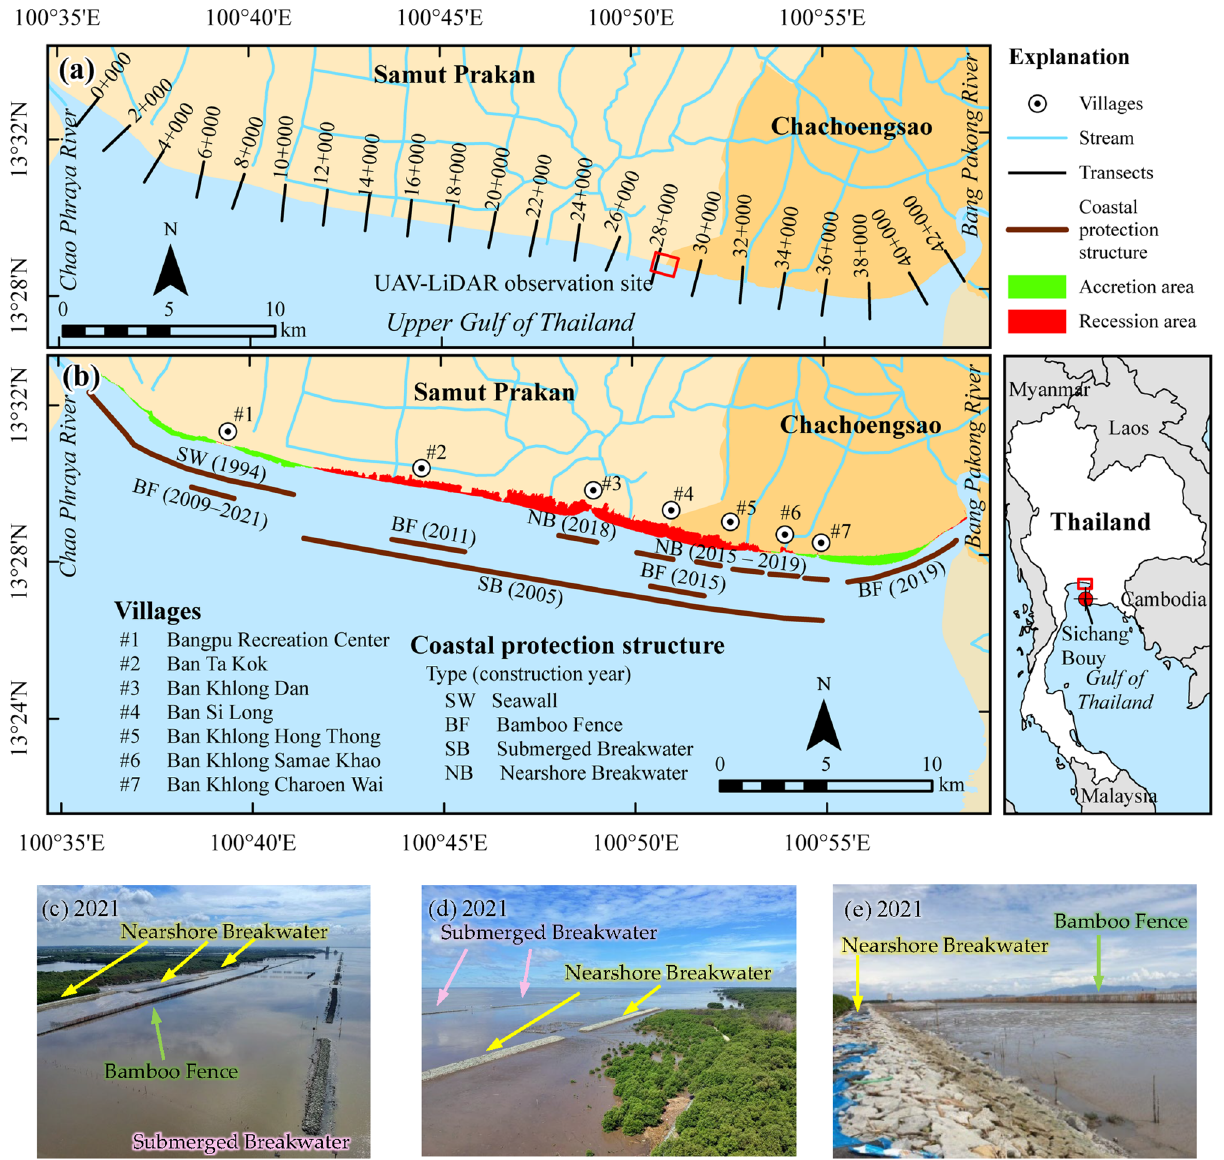
Figure 1. ( a ) Shoreline change measurement stations used in this study. The red box shows the LiDAR survey area. ( b ) Types of coastal structures and their alignment along the ECPD coastline. Red and green patches along the shore represent land loss and land accretion during 1954–2002. The maps were generated using ArcMap software version 10.6 ( © ESRI, https:// deskt op. arcgis. com). ( c ) The location of nearshore breakwaters, bamboo fences, and submerged breakwaters placed east of Ban Si Long. ( d ) The location of nearshore and submerged breakwaters placed west of Ban Si Long. ( e ) The crest of nearshore breakwaters above the seabed is typically lower than that of bamboo fences (The images c – e were taken by